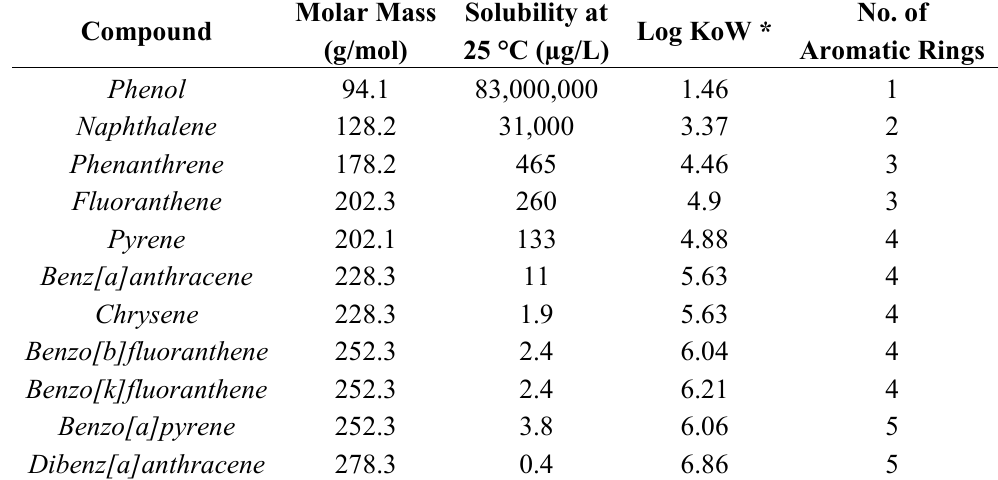
Table 6. Aromatic compounds detected in Walloon Coal Measures CSG water and leaching experiments with their physico-chemical properties [57,58]. Molar Mass Compound